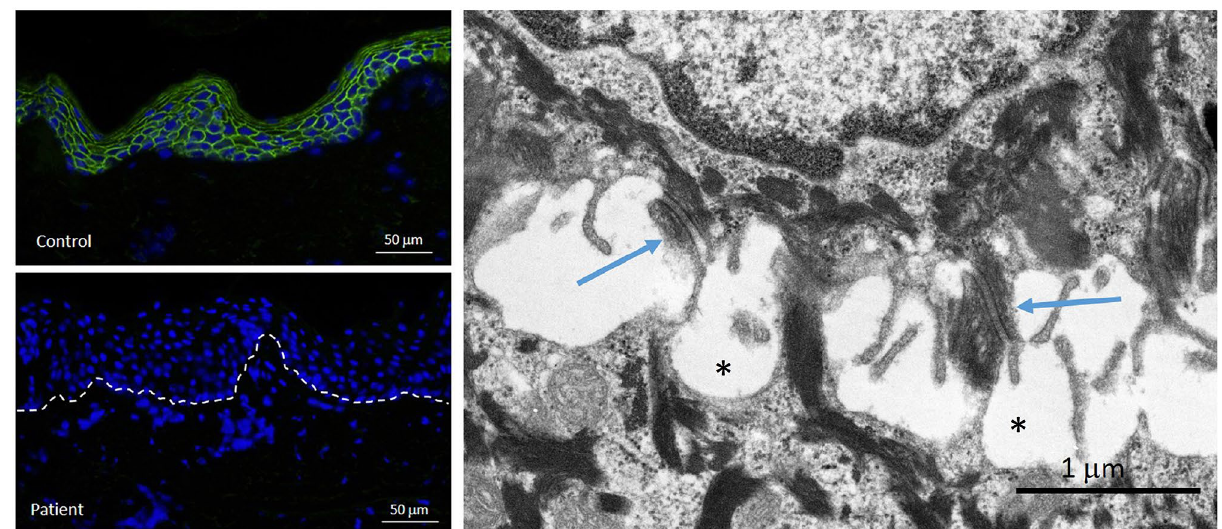
Figure 4. Immunofluorescence and transmission electron microscopy analysis of skin biopsy from Patient 2. IF staining for junction plakoglobin (encoded by JUP ) shows complete absence of the protein in the epidermis of the patient (left lower panel) compared to pan-epidermal keratinocyte cell membrane labeling in an unrelated individual’s healthy skin (left upper panel). Ultrastructurally (right panel), desmosomes appear somewhat small with pinching off within the intercellular desmosomal plaques (arrows) and widening of the intercellular spaces between adjacent keratinocytes (asterisks). For technical details see reference 44